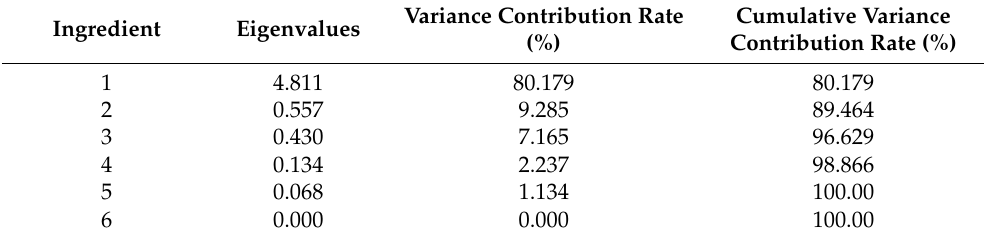
Table 2. Eigenvalues and cumulative variance contribution rates of membrane evaluation